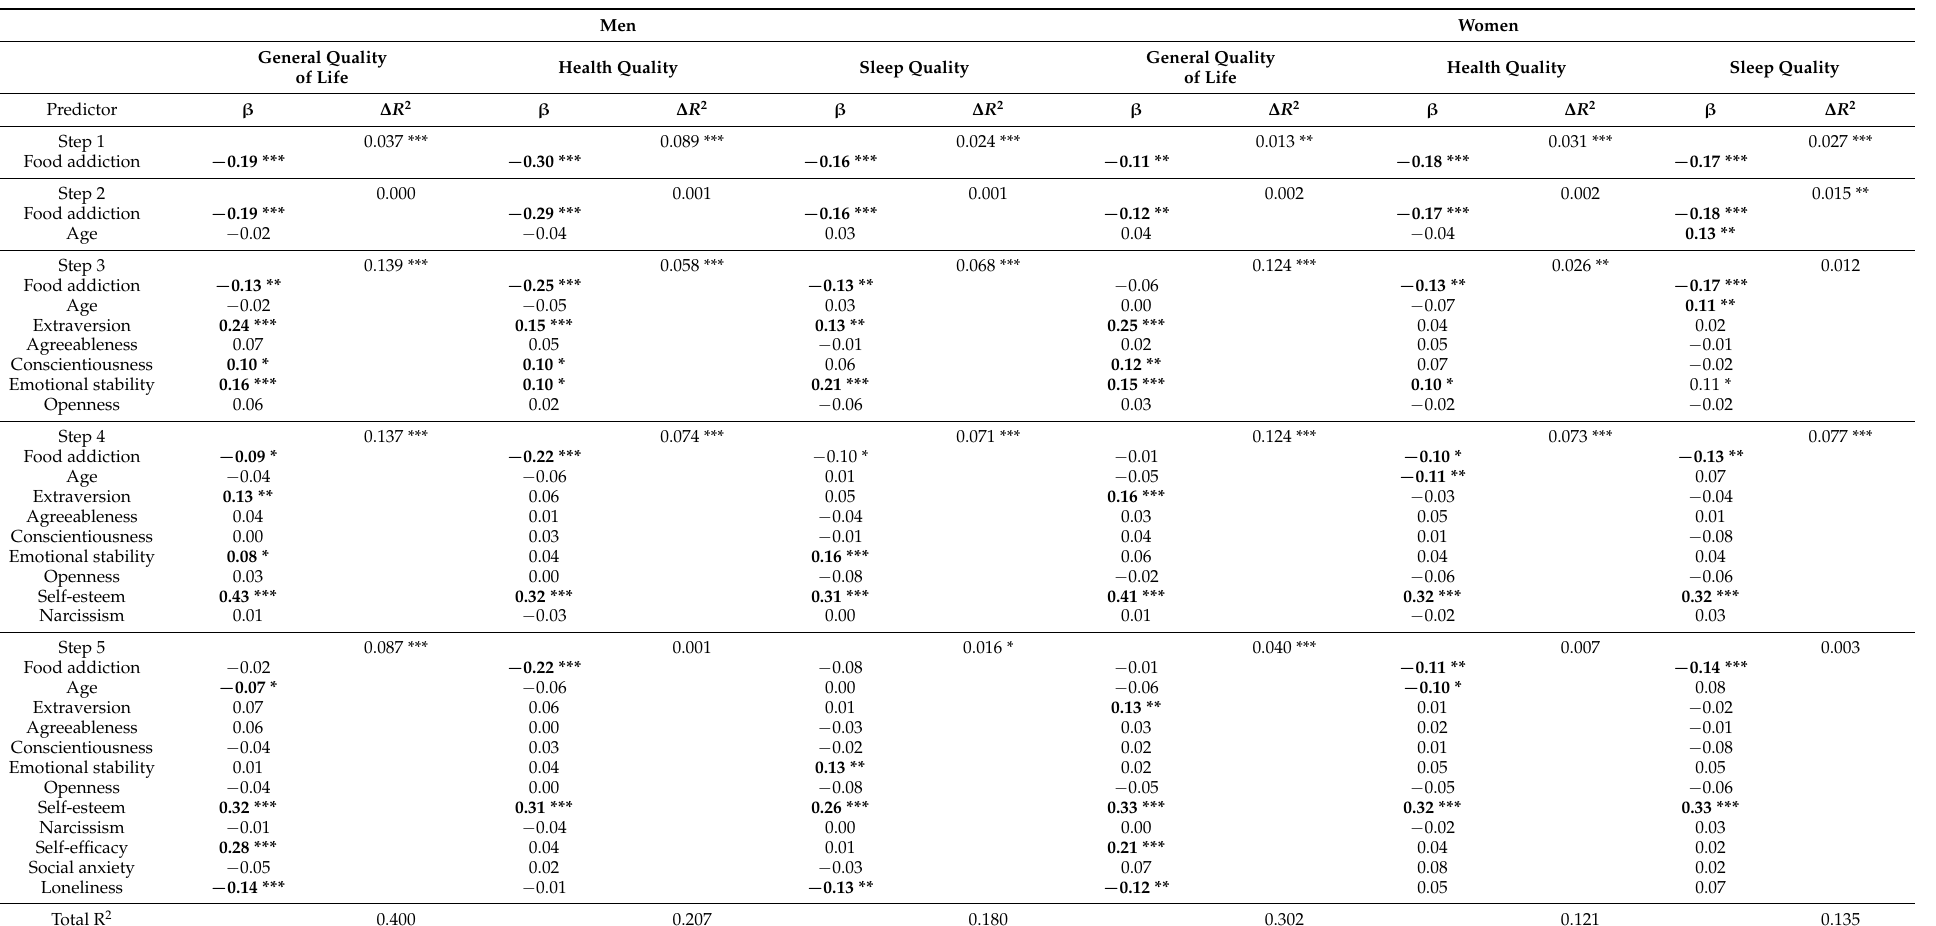
Table 6. Results of hierarchical multiple regression analyses: Food addiction, age, personality, self-esteem, narcissism, self-efficacy, social anxiety, and loneliness as predictors of quality of life among men ( n = 546) and women ( n =